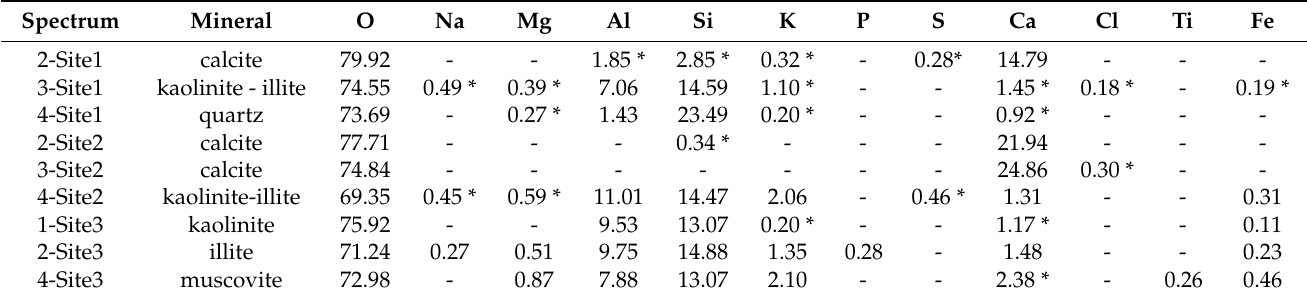
Table 5. Semi-quantitative analysis of C3 sample in atoms